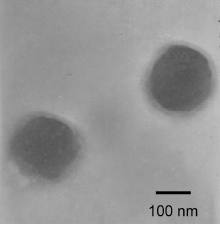
Figure 1. TEM image of hollow nanocapsules prepared though the stabilization of PAMAM dendron-PLL self-assembled polymer vesicles by introducing disulfide bonds. Type of Nanocapsules Table 1. Preparation of hollow nanocapsules for DOX delivery. *